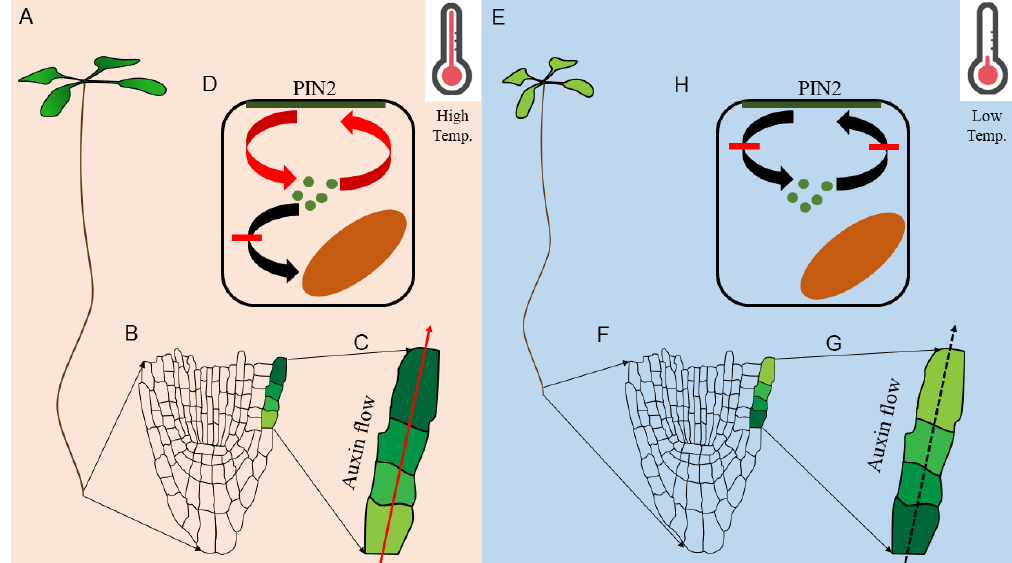
Figure 5. Altered auxin homeostasis in root under high and low temperature. Elongated root growth at high temperature ( A ). Meristematic region and representative epidermal cells (shaded in green color based on auxin level) are demonstrated ( B ) along with the direction of auxin flow and accumulation ( C ). High temperature-mediated PIN2-targeting to the plasma membrane ( D ). Inhibited root growth at low temperature ( E ). Meristematic region and representative epidermal cells (shaded in green color based on auxin level) are demonstrated ( F ) along with the direction of auxin flow and accumulation ( F ). Low temperature mediated PIN2 trafficking inhibition to the plasma membrane ( H ).